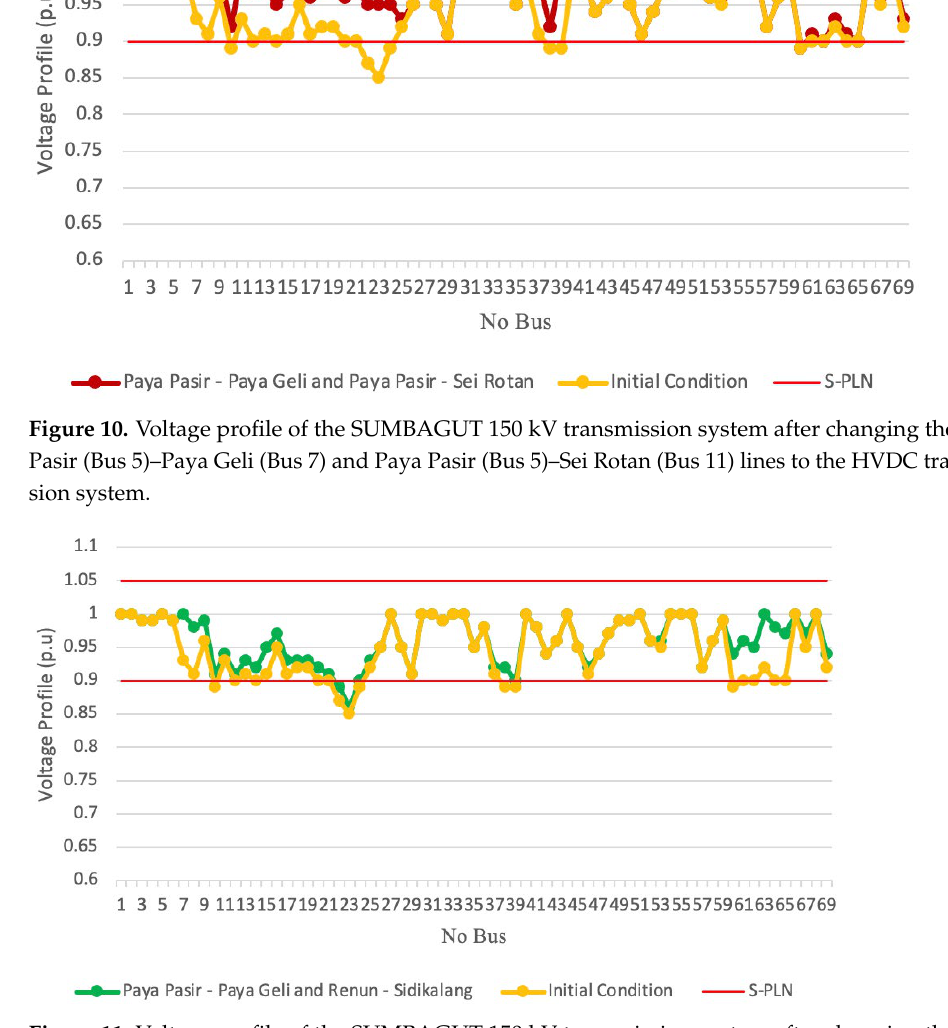
Figure 11. Voltage profile of the SUMBAGUT 150 kV transmission system after changing the Paya Pasir (Bus 5)–Paya Geli (bus 7) and Renun (Bus 66)–Sidikalang (Bus 63) lines to the HVDC transmis- sion system.